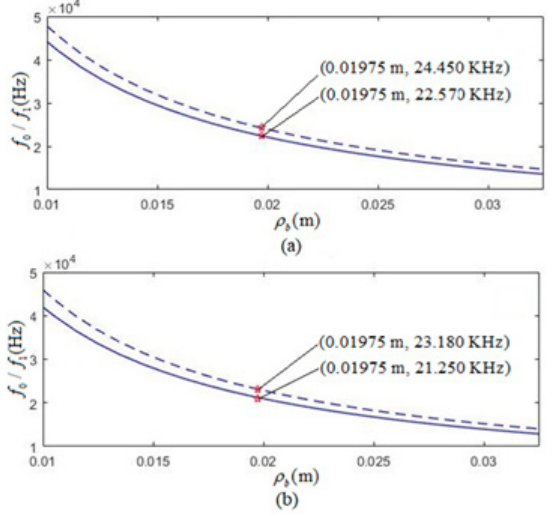
Figure 5. Relationship of both the free resonant frequency f 0 and loading resonant frequency f 1 versus its average radius ρ 0 of tangentially and radially polarized thin cylindrical piezoelectric transducers. The dotted line is the case with free mechanical load, and the solid line is that with the mechanical load. ( a ) Tangentially polarized thin cylindrical piezoelectric transducer; ( b ) Radially polarized thin cylindrical piezoelectric